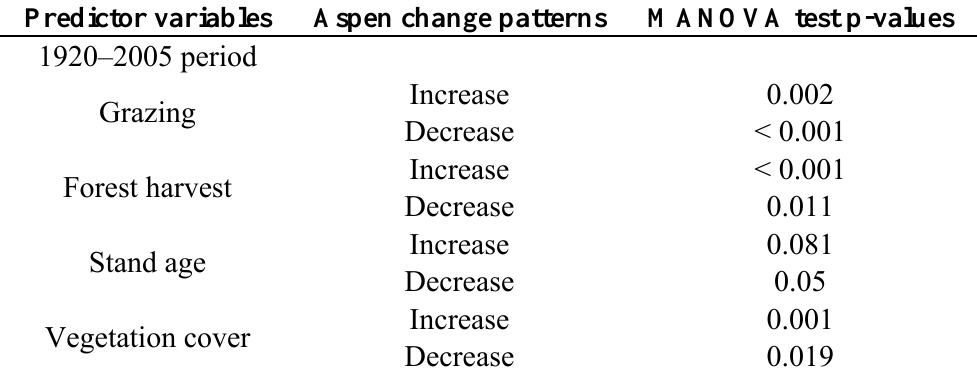
Table 3. Predictor variables examined with aspen change patterns over the two time